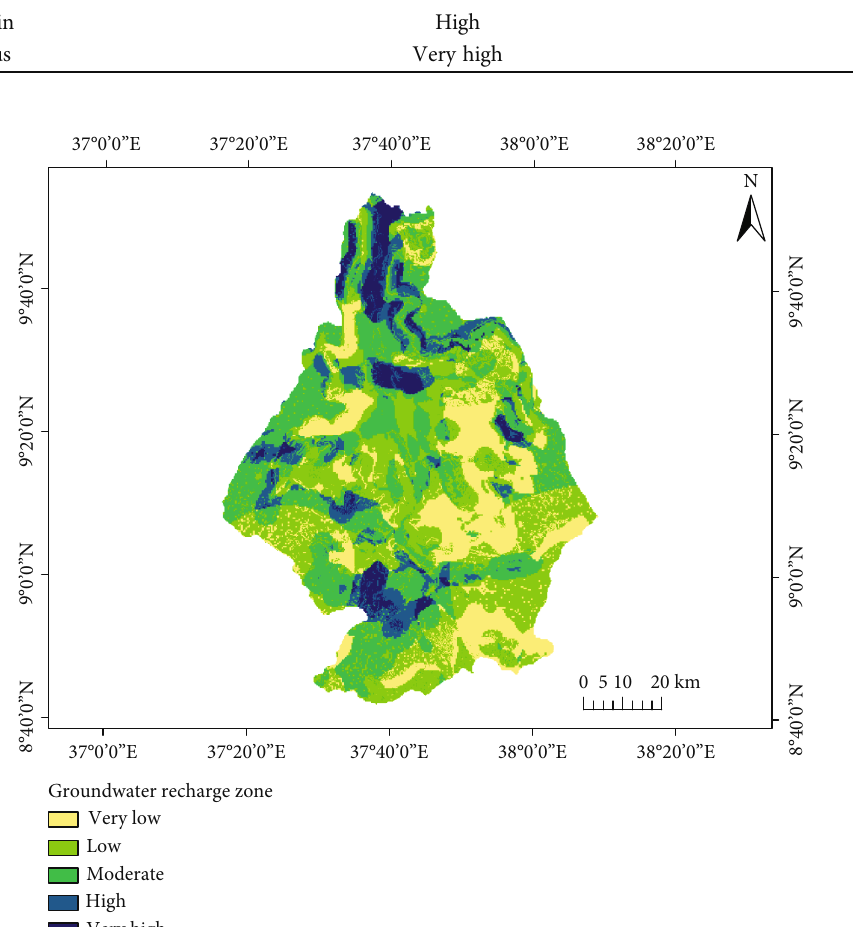
Figure 11: Groundwater recharge zones of the study area.